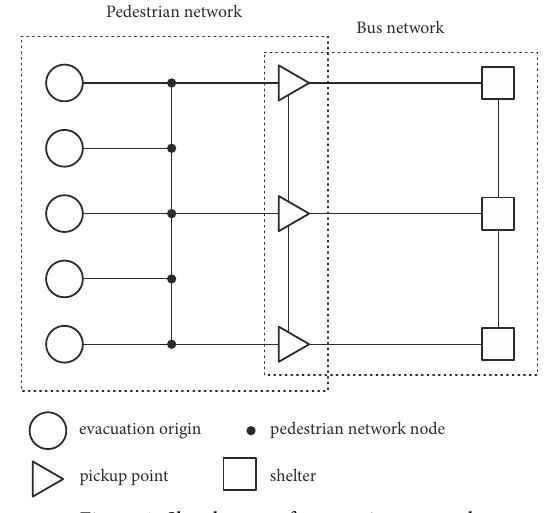
Figure 1. Sketch map of evacuation Table 1. Comparison of key elements in recently related evacuated model